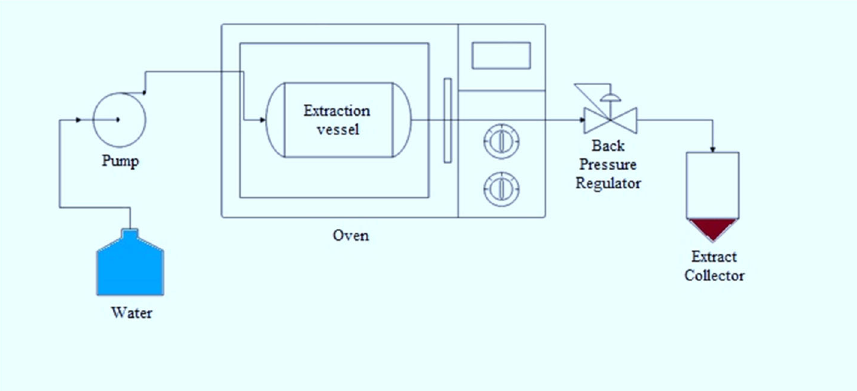
Figure 1. The SWE schematic diagram.